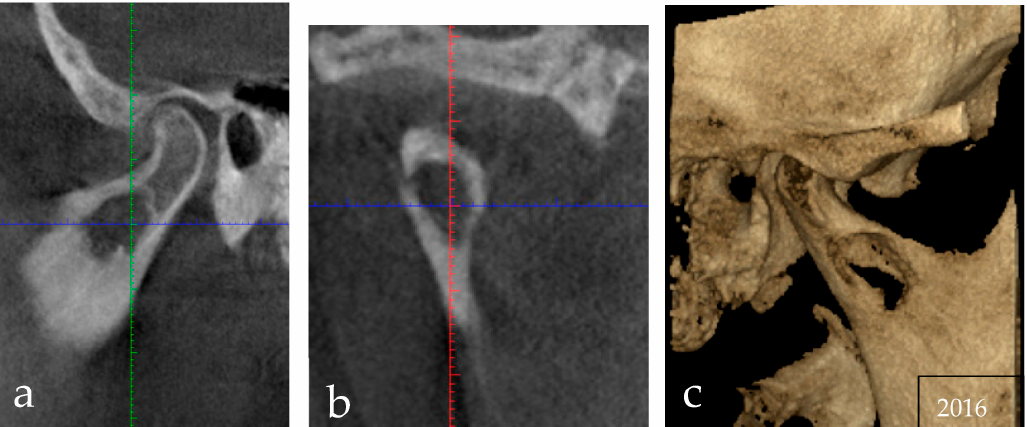
Figure 3. Preoperative cone-beam computed tomography (CBCT) with multiplanar reconstructions showing a unilocular osteolytic lesion, with relatively well-defined but irregular borders and sclerotic margin, extending into the right mandibular condyle; there was not, however, cortical expansion or deformation of the condylar process: ( a ) sagittal view, ( b ) coronal view, ( c ) three-dimensional reconstruction. Images were obtained at 120 kVp e 3.8 mA and reconstructed using voxel size of 0.3. The green line is the indicator line of the coronal slice in the sagittal sections, the red line is the indicator line of the sagittal slice in the coronal sections, and the blue lines are the indicator lines of the axial slices in the sagittal ( a ) and coronal ( b )